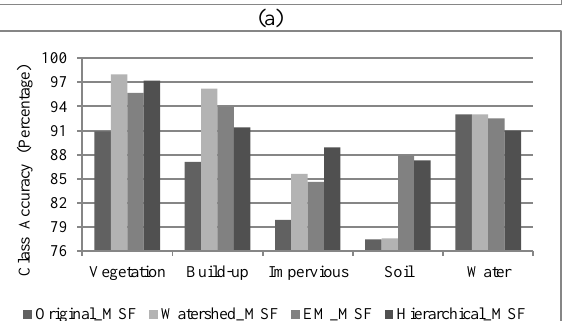
Figure 5. Berlin image, (a) color composite image, (b) Reference data: vegetation, build-up, impervious, soil and water. (c) Original-MSF classification map, (d) Watershed-MSF classification map, (e) EM-MSF classification map, (f) Hierarchical-MSF classification map.